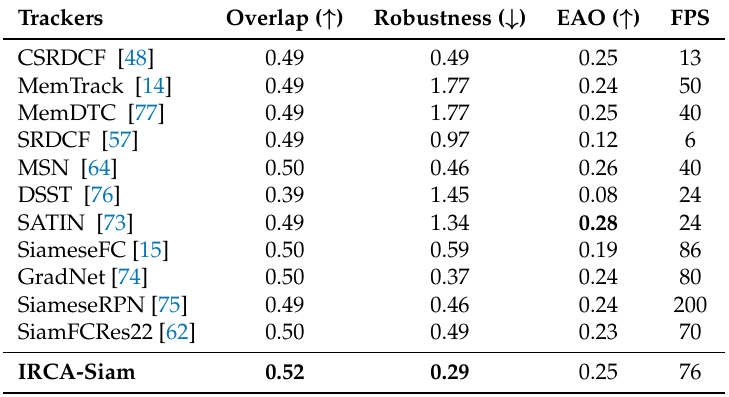
Table 5. Performance comparison for different trackers over VOT2017.